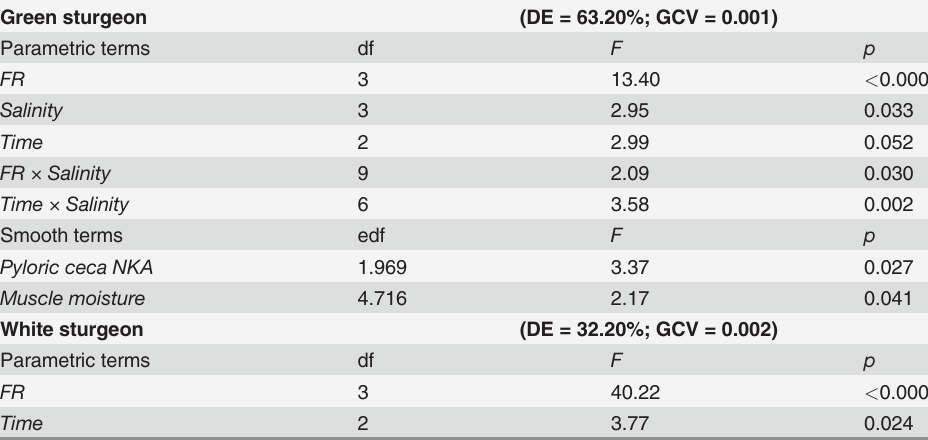
Table 2. Significance of final models ’ terms.